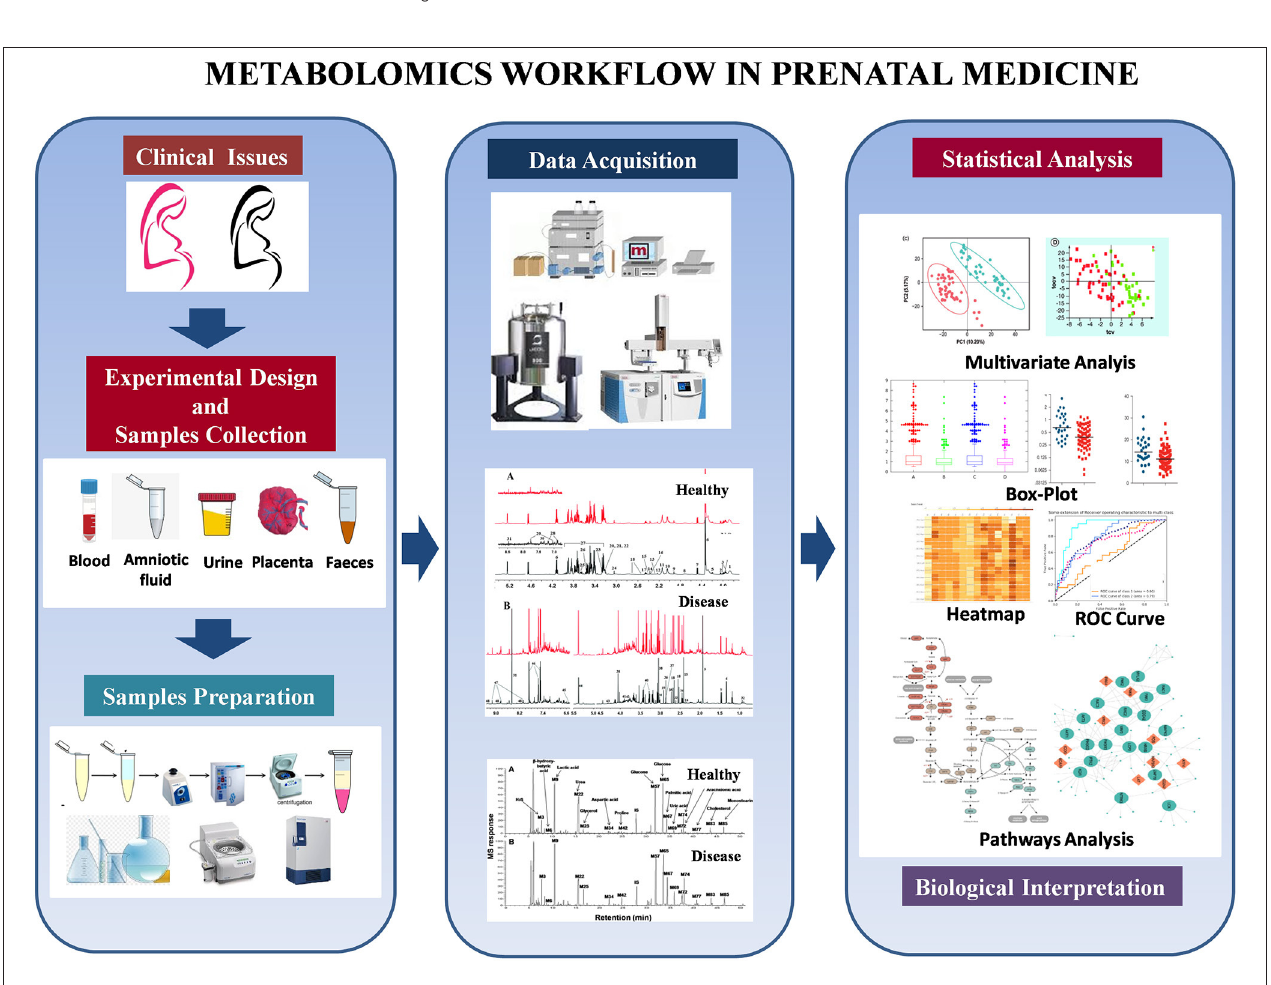
FIGURE 2 | Metabolomics workflow in prenatal